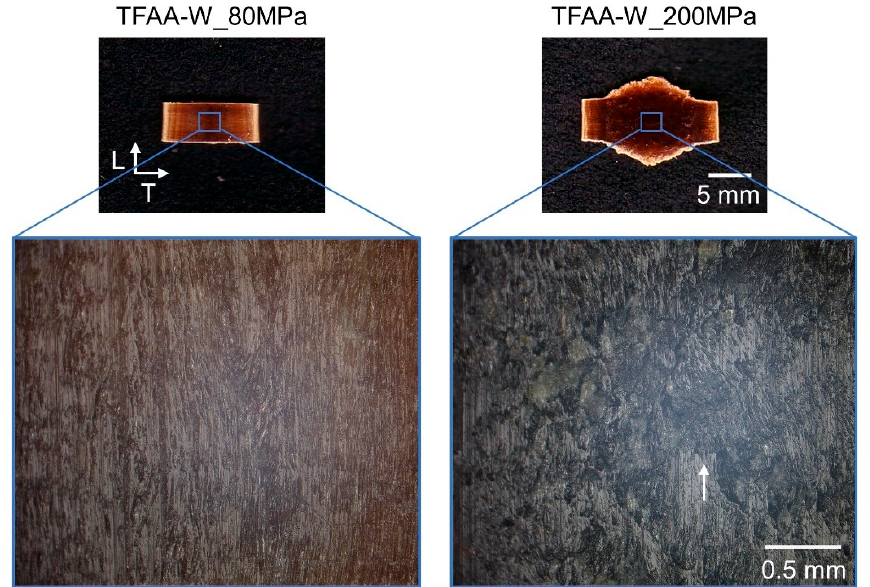
Figure 9. Photographs and microscopic images of TFAA-W specimens after hot compression tests at 80 or 200 MPa. The arrow indicates a typical tear of the wood fibers.